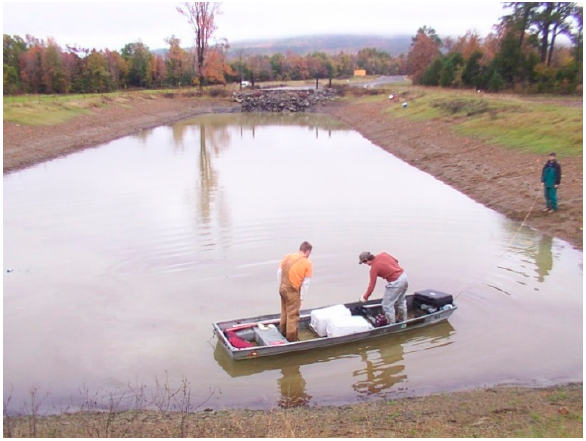
Figure 2. One settling pond used for storage in the study area.